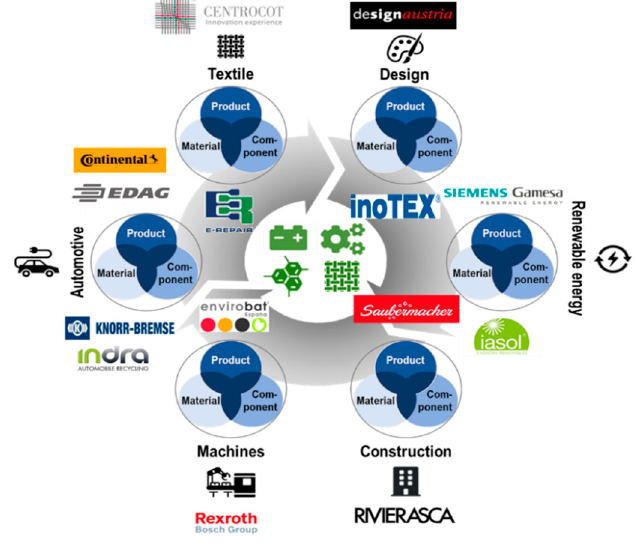
Figure 2. DigiPrime Pilots